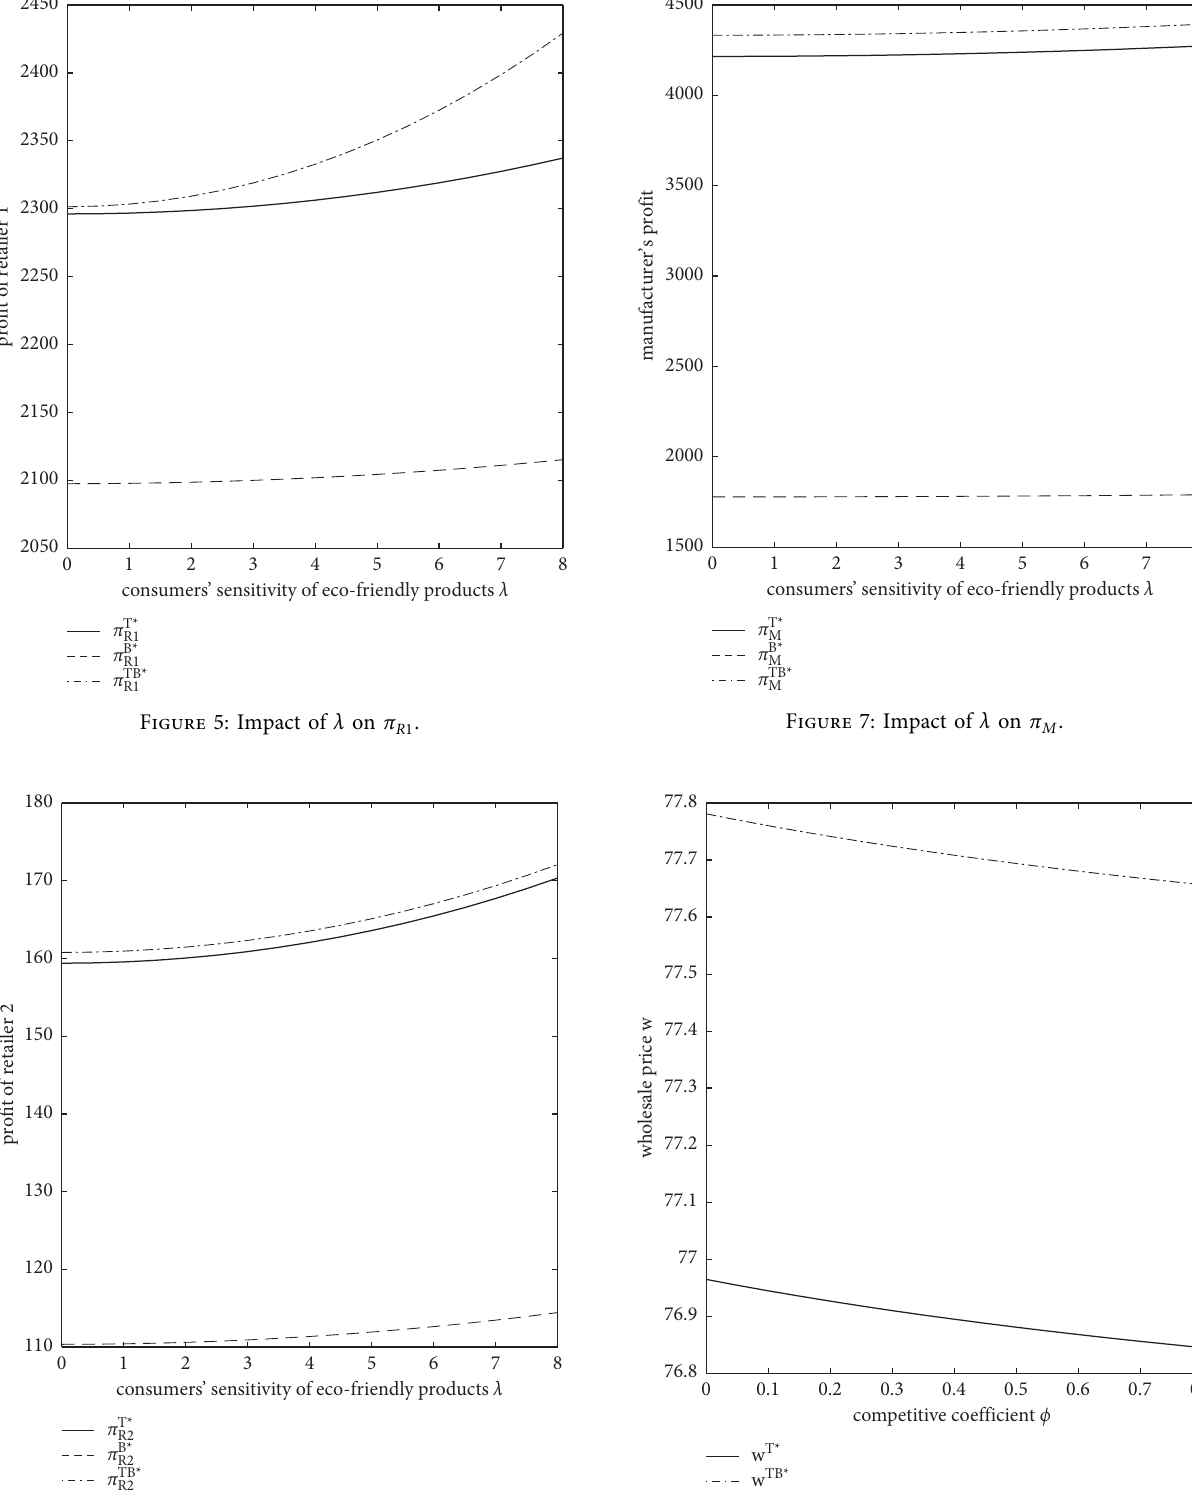
Figure 6: Impact of λ on π